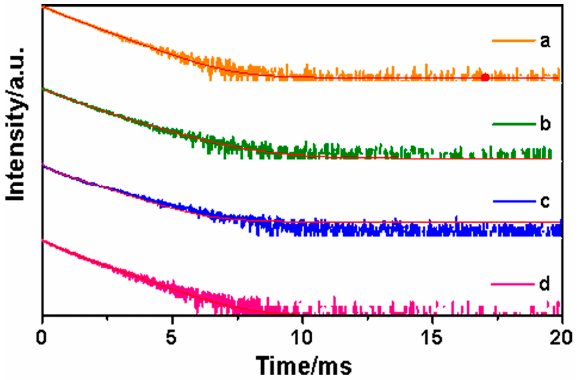
Figure 10. Figure 10. Decay curve of SiO 2 @PMDA-Si-Tb ( a ), SiO 2 @PMDA-Si-Tb@SiO 2 ( b ), SiO 2 @PMDA-Si- Tb-phen ( c ) and SiO 2 @PMDA-Si-Tb-phen@SiO 2 ( d